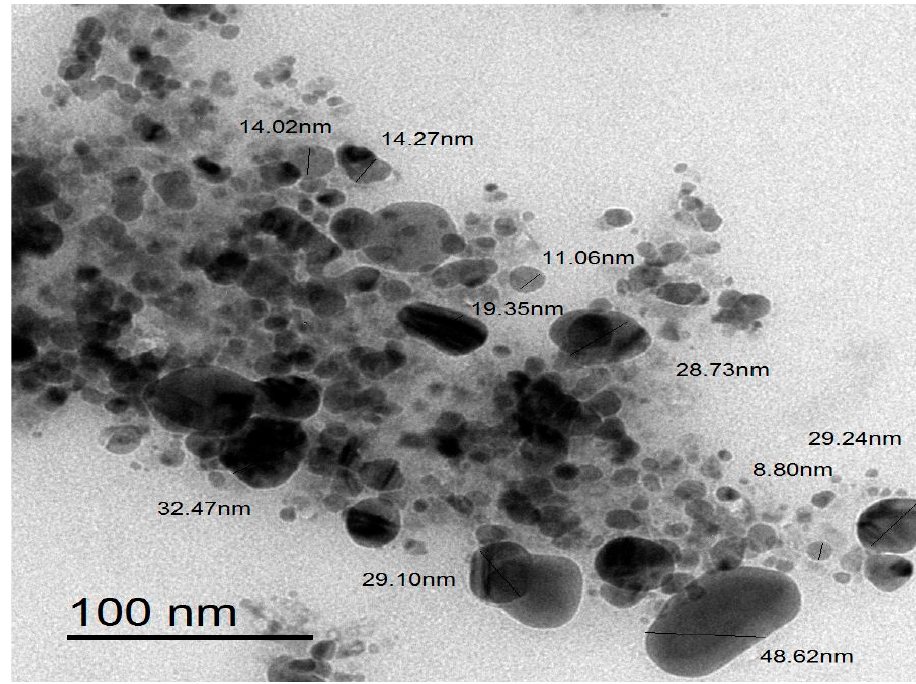
Figure 5. TEM graph of the bioproduced ZnO-NPs.